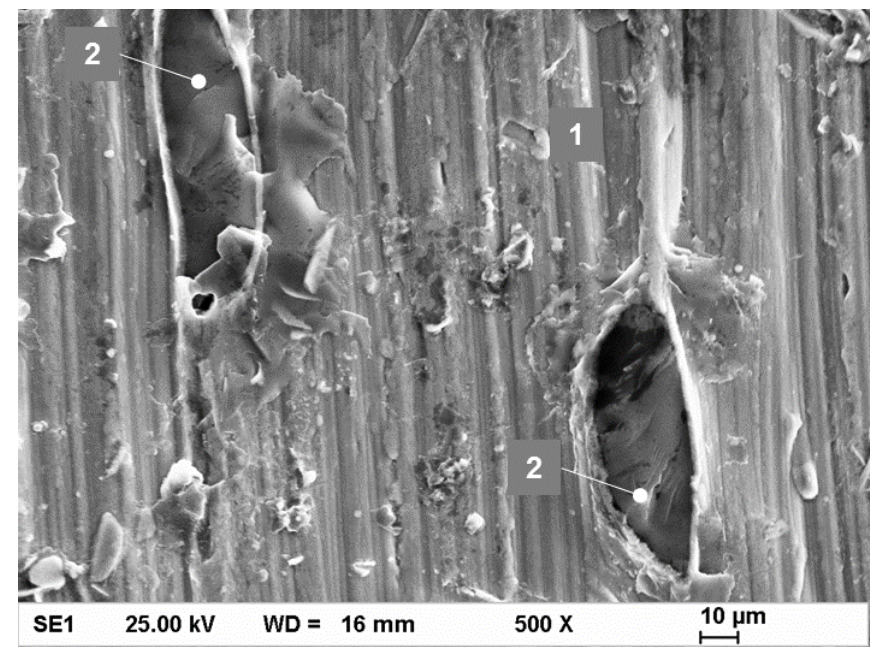
Figure 11. SEM image of a fracture surface of an AA 6060 and AZ 31B joint with titanium interlayer on the aluminium side revealing ( 1 ) the surface of the titanium coating with only a few areas of ( 2 ) intermetallic Al-Mg compounds.